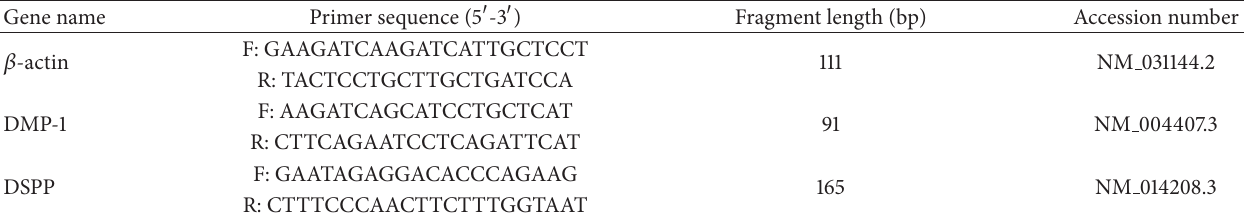
Table 1: Forward (F) and reverse (R) primer sequences for target and reference